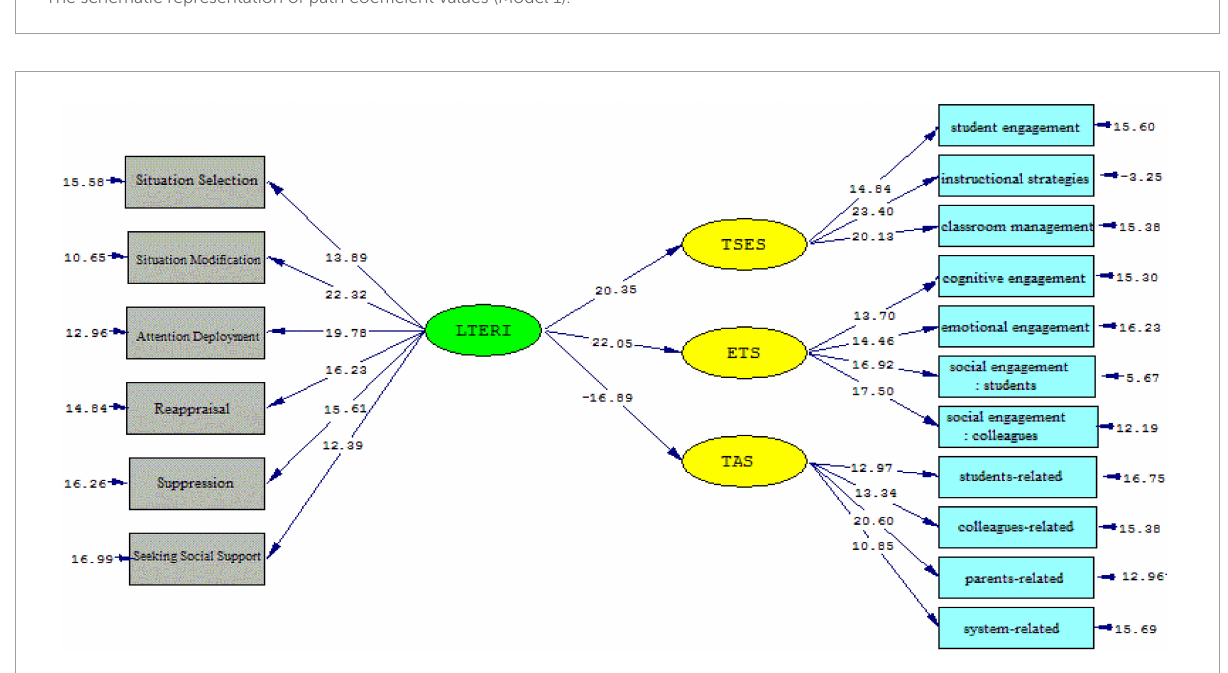
FIGURE3 T -values for path coefficient significance (Model